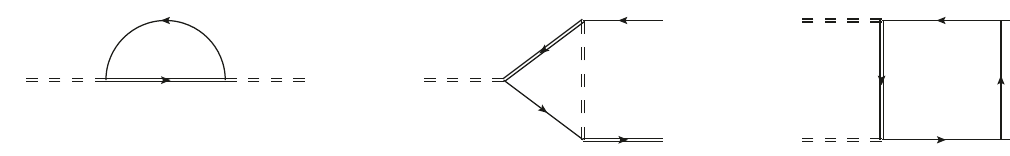
Figure 10 . Examples of one-loop diagrams relevant for the running couplings y and (cid:21) 3 . From left to right we have displayed the self-energy diagram for the scalar DM, the Yukawa triangle vertex and the box-diagram. Dashed double lines stand for the DM, solid duble line for the mediator, thn solid lines for the SM right-handed quarks. In the latter diagram, the thin solid lines stand for the right-handed top and left-handed quark doublet attached to the Higgs boson external